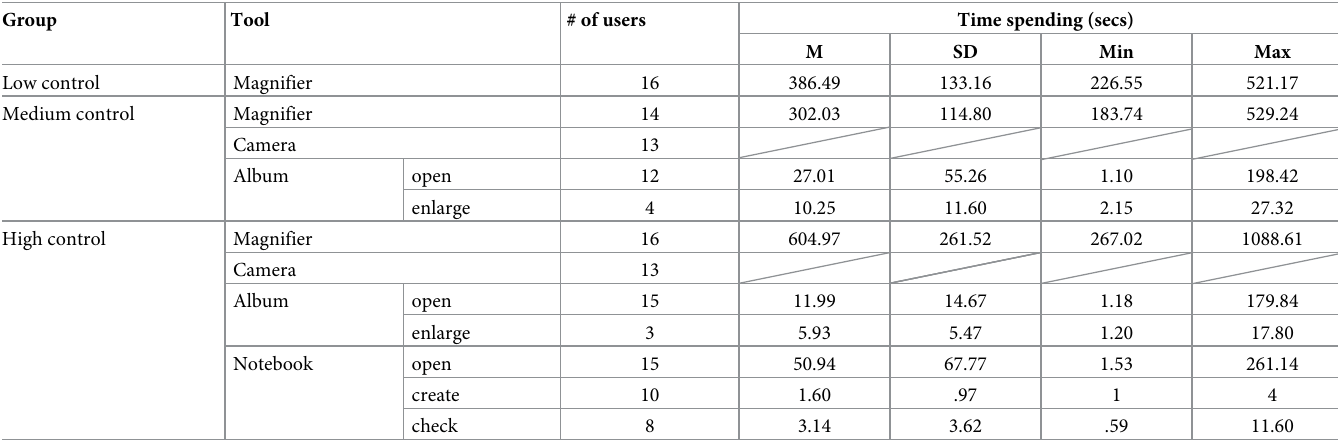
Table 9. Time spent using each AR tool in the three groups. Group